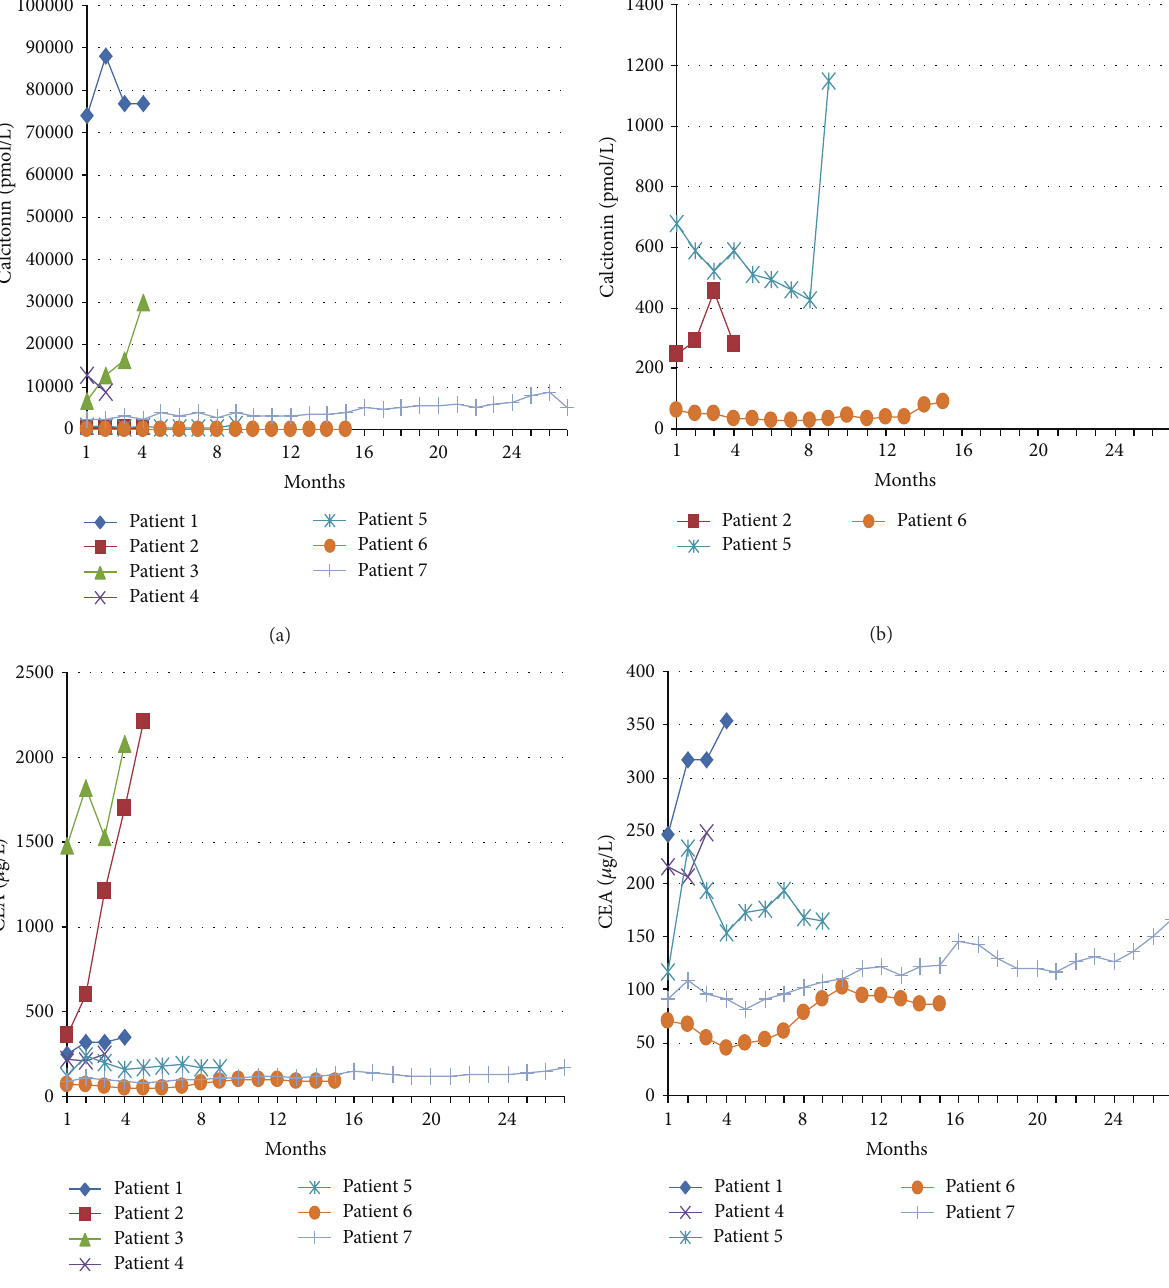
reflects the radiological response, these changes were not always significant in our study and we were unable to confirm this correlation [11,